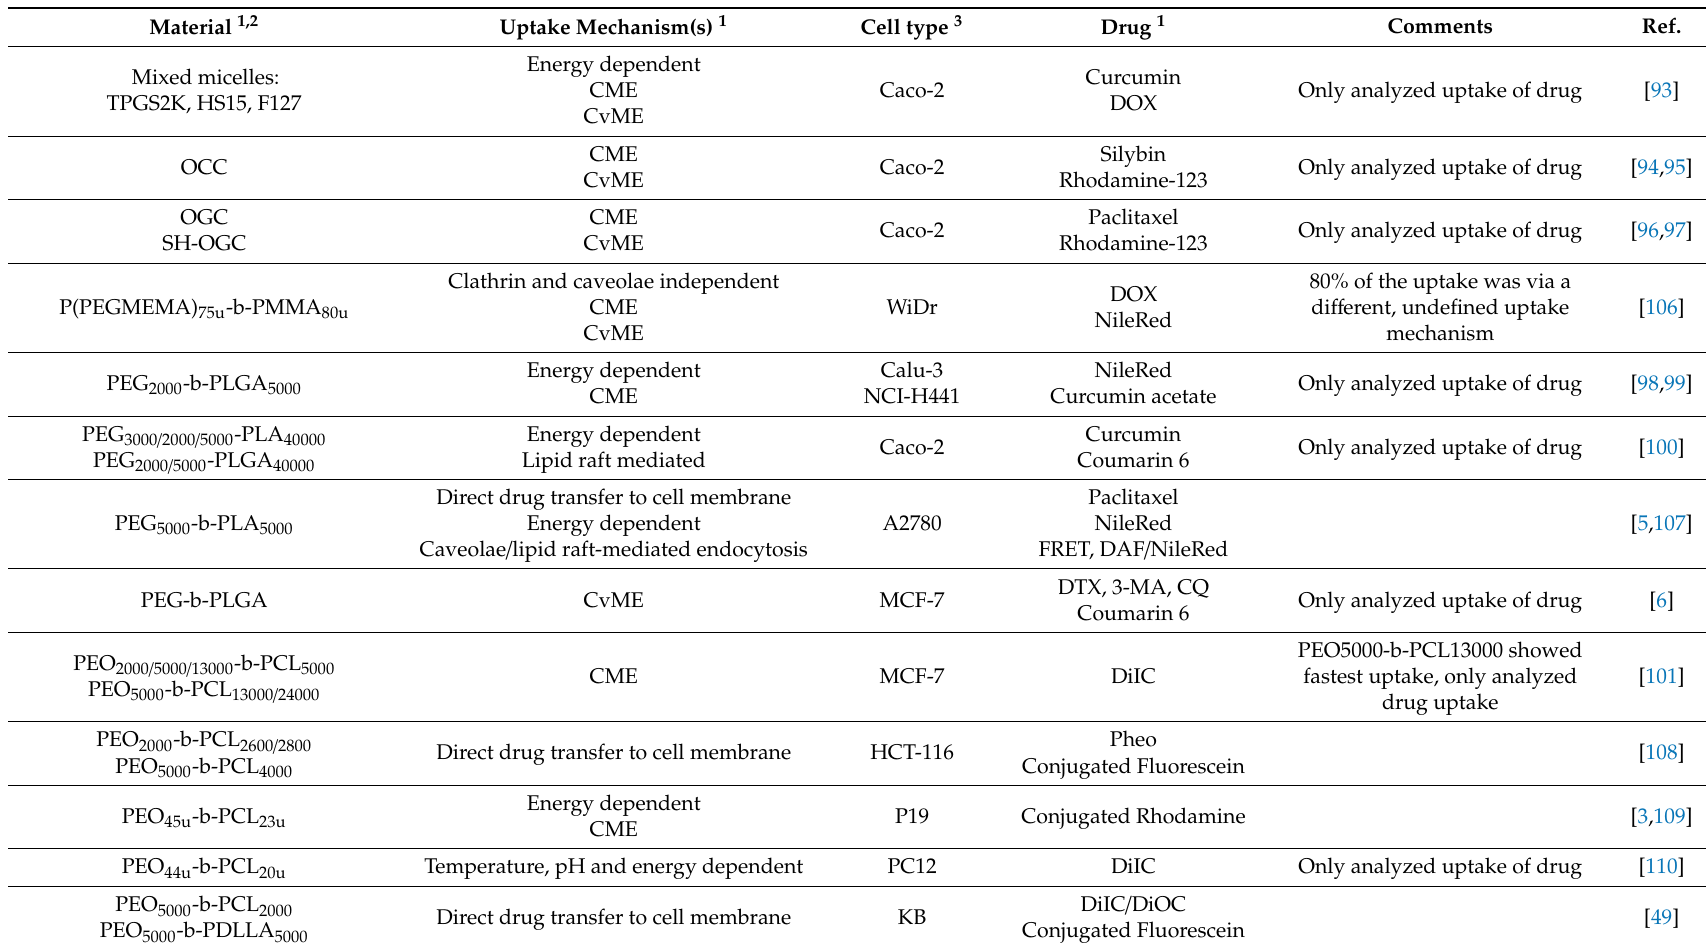
Table 2. Overview of the proposed uptake mechanisms of di ff erent polymeric